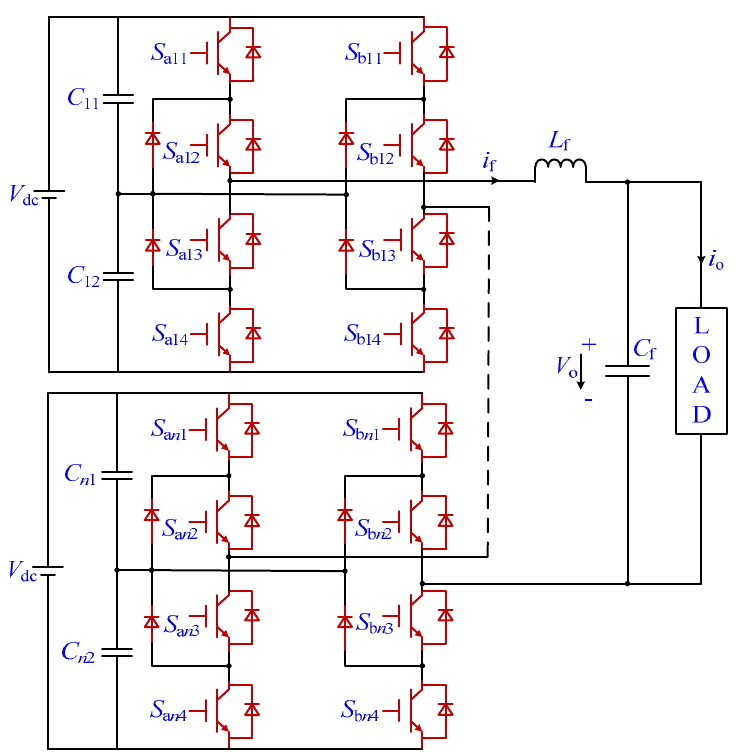
Figure 1. The structure of the voltage mode digital power amplifier employing CFNPCI.